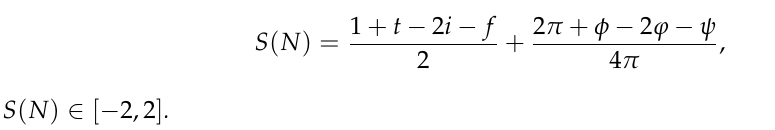
Table 3. Incidence matrix of